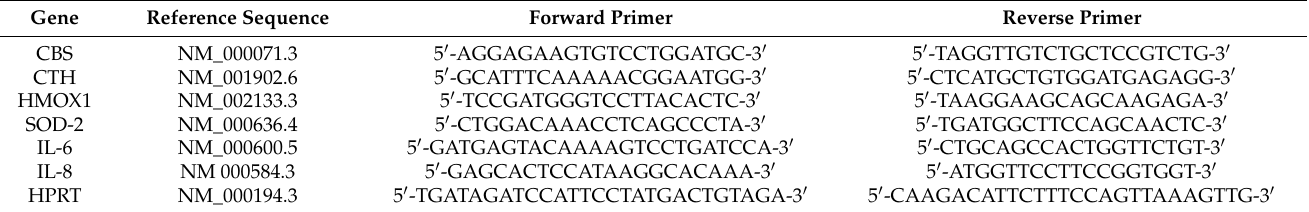
Table 2. Sequences of the primers used to analyze gene